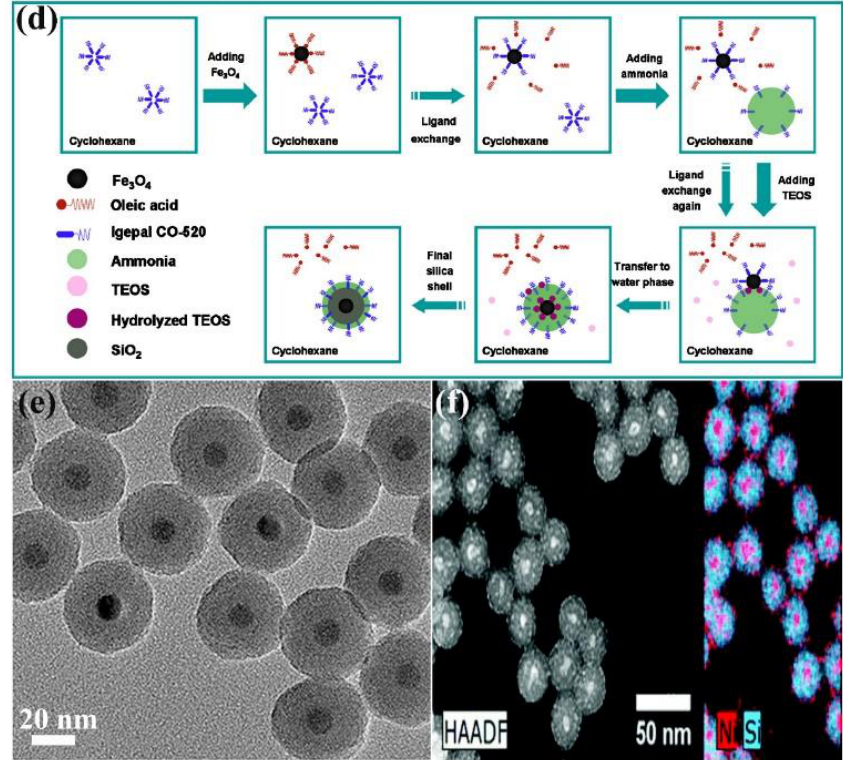
Figure 2. Synthesis of SNs via reverse microemulsion method. ( a ) Schematic diagram of the nucle- ation and growth mechanism of HSNs. Adapted with permission from [46]. Copyright 2015, Royal Society of Chemistry. ( b ) TEM images of unetched solid SNs and ( c ) TEM images of HSNs. Adapted with permission from [46]. Copyright 2015, Royal Society of Chemistry. ( d ) Schematic diagram of the mechanism coating SiO 2 on the surface of Fe 3 O 4 nanoparticles. Adapted with permission from [49]. Copyright 2012, American Chemical Society. ( e ) TEM image of Fe 3 O 4 @SiO 2 nanoparticles. Adapted with permission from [49]. Copyright 2012, American Chemical Society. ( f ) HAADF-STEM images and EDS maps showing Ni and Si of SiO 2 -Ni NPs. Adapted with permission from [52]. Copyright 2017, Royal Society of